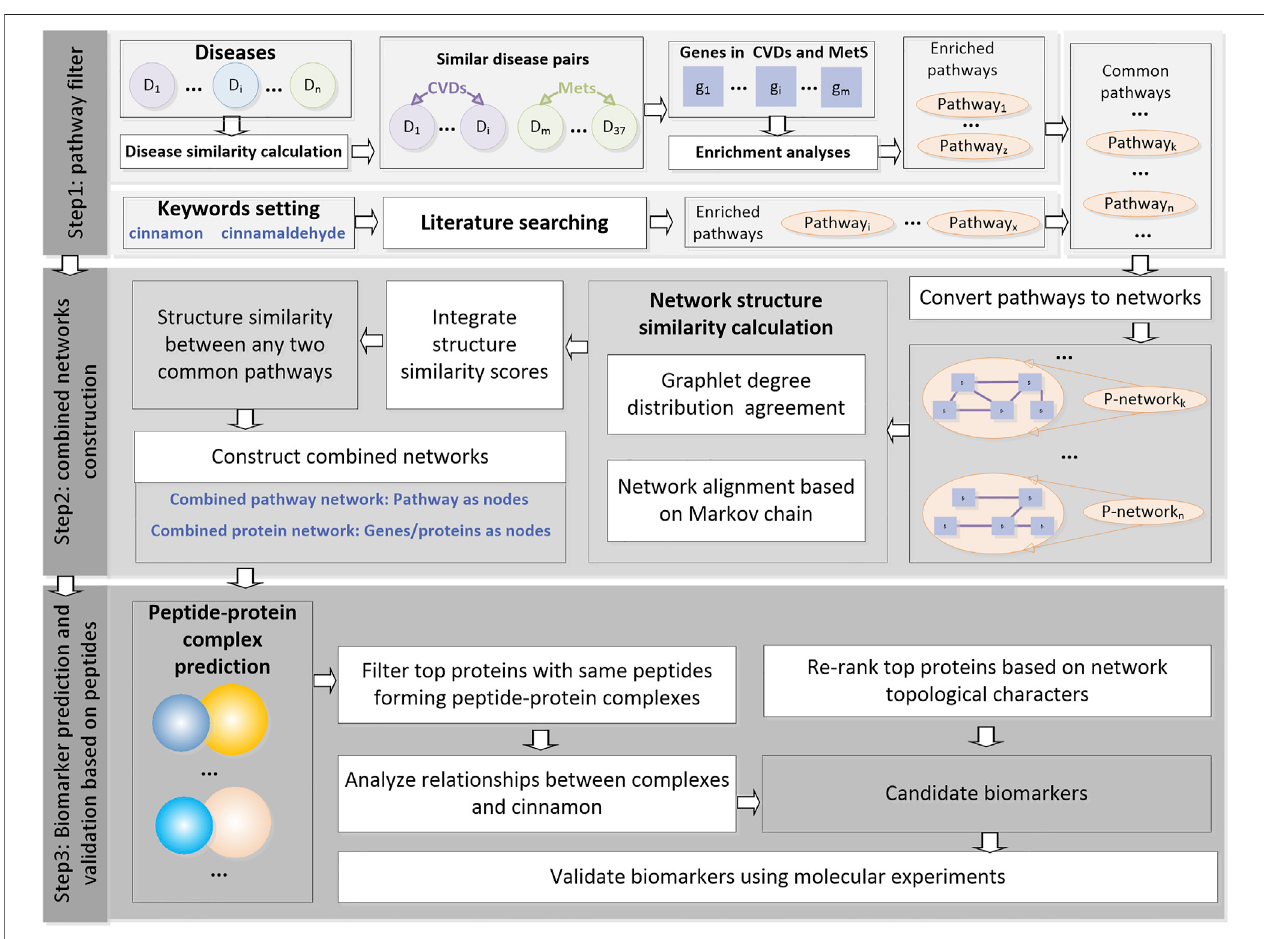
FIGURE1| Flowchartofthisstudy.Thispipelineconsistsofthreesteps,namely, “ pathway fi lter, ”“ combinednetworkconstruction, ” and “ biomarkerpredictionand validation based on peptides.